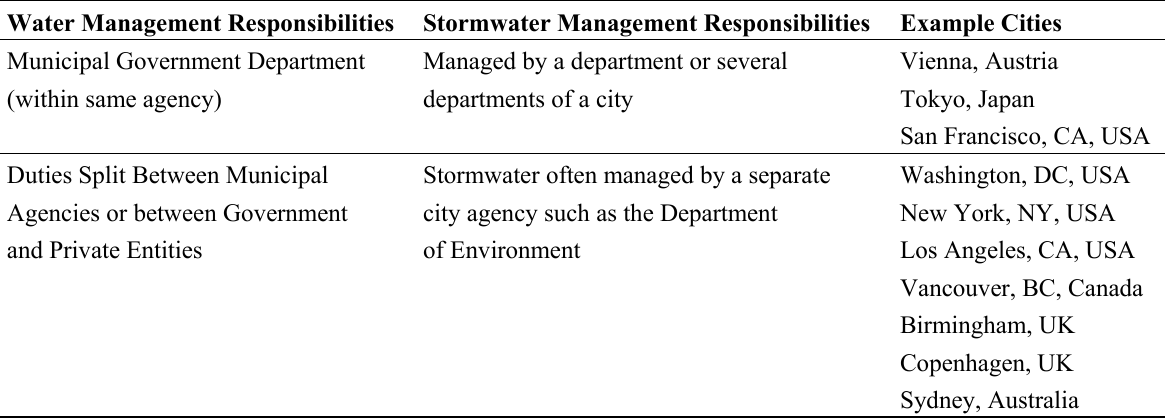
Table 1. Organizational Structures for Stormwater Management in Industrialized